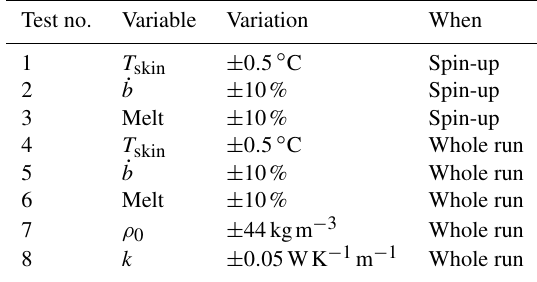
Table 3. List of sensitivity tests conducted for determining the model